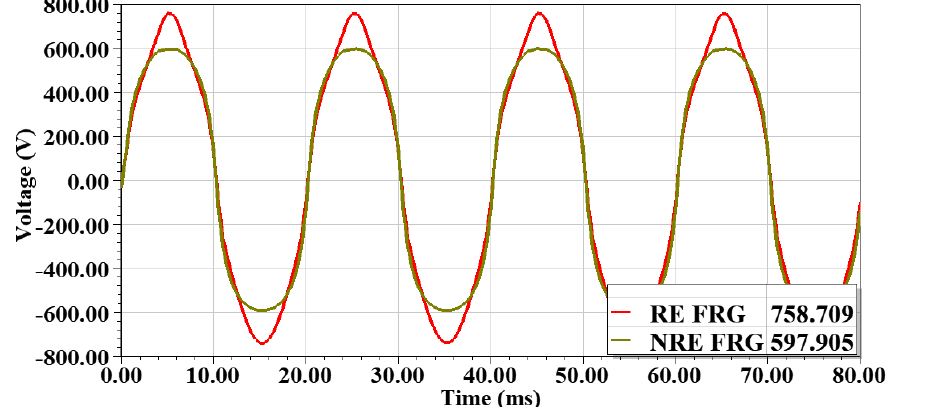
Figure 4. No-load voltage comparison at 375 r/min.